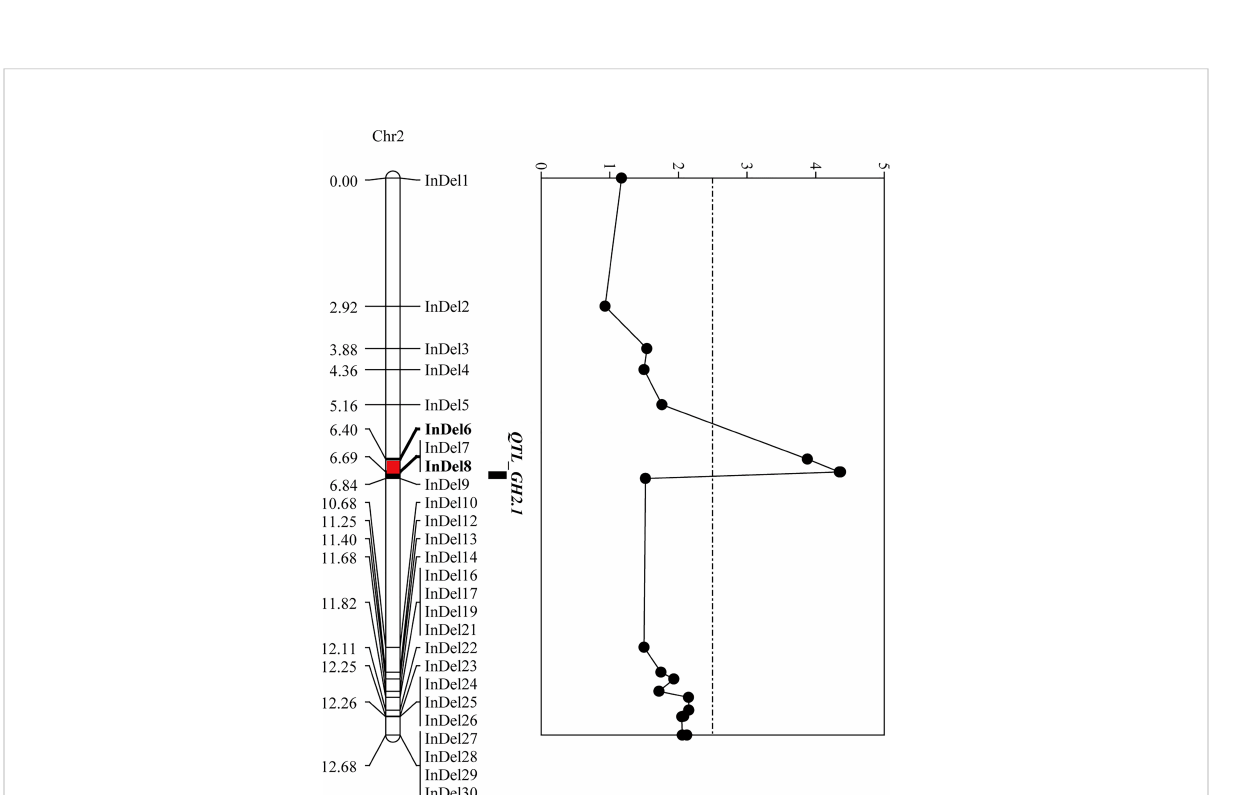
FIGURE 5 Fine-mapping of GH2.1 by linkage analysis. The left panel exhibits the linkage map, in which the red segment indicates the positioning interval of GH2.1 . The right panel shows the LOD value of each locus in F 2:3